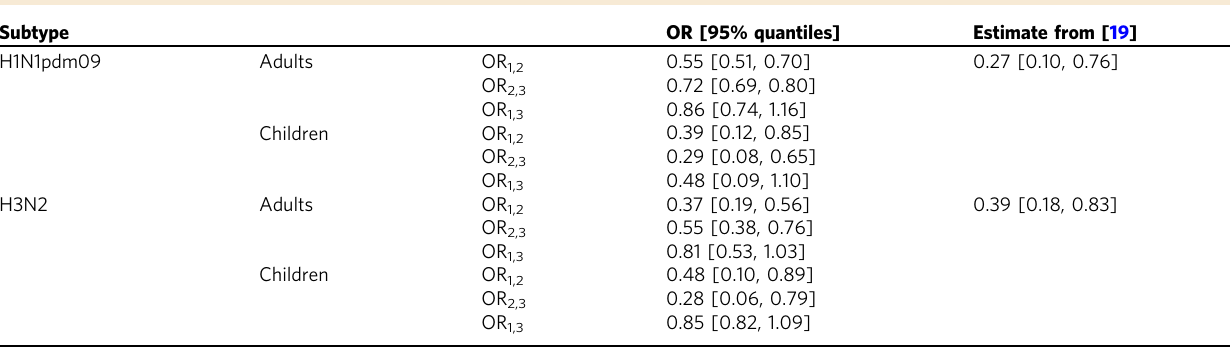
Oddsratiosare predictedfrom1000replicatesimulationsof themodelsforH1N1pdm09andH3N2at theMLEs.EpidemicsarenumberedasinFig.3.Therightmost columnshows oddsratiosestimated using ≥ 4-fold changes in titer as an indicator of